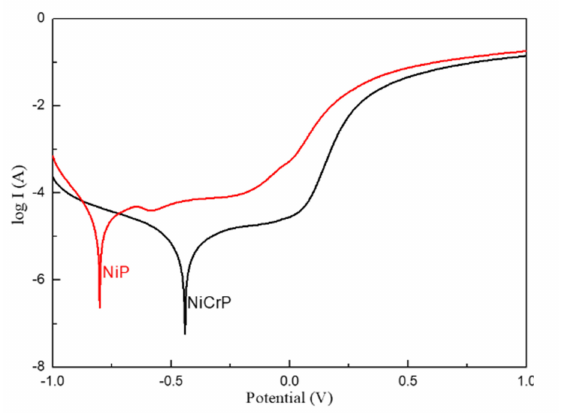
Figure 11. Anodic polarization curves of the alloy coatings in a 3.5 wt.% NaCl solution at room temperature. Table2. Corrosionpotentialandcorrosioncurrentdensityofthealloycoatingsin3.5wt.%NaClsolution.